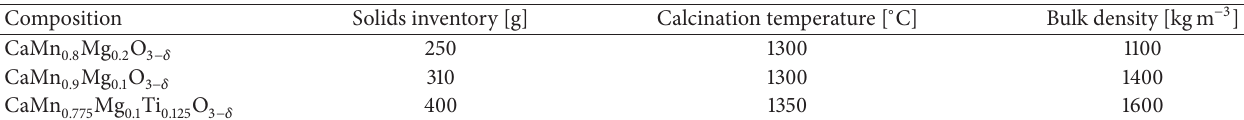
Table 1: Material data.